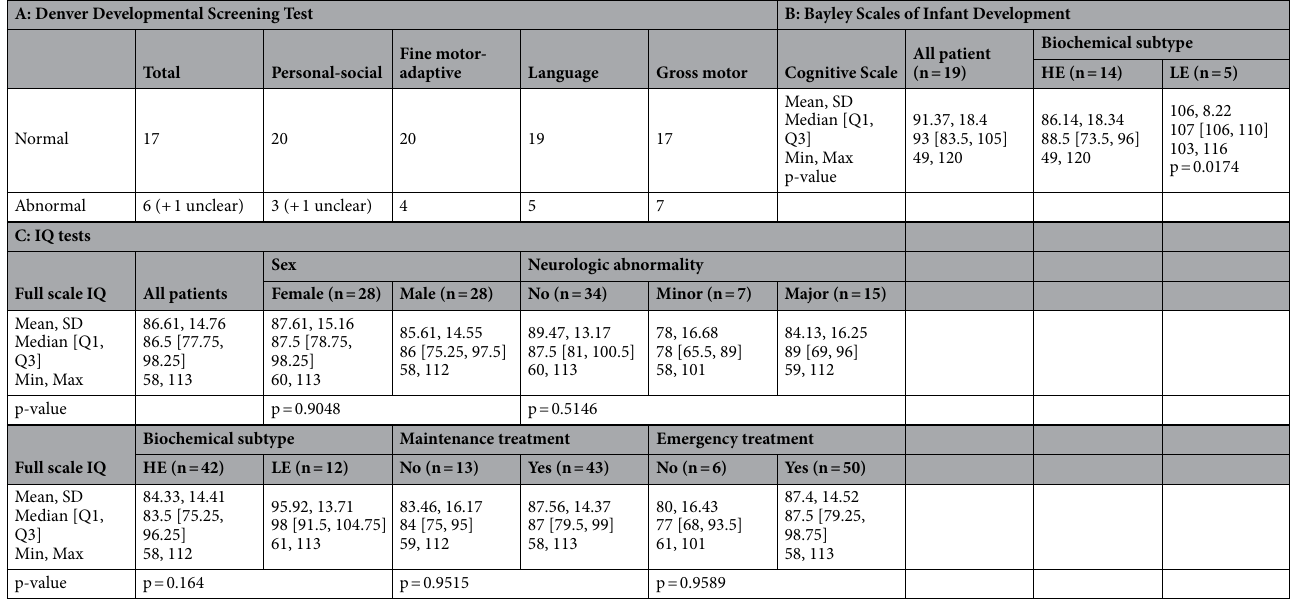
Table 2. Cognitive outcome: development and full scale IQ of individuals identified by NBS. (A) Most patients assessed with Denver Developmental Screening Test showed normal development. (B) Median results in Bayley Scales of Infant Development were normal with HE patients showing lower results than LE patients. (C) Analysis of full scale IQ: Median results of all patients were in the lower average range, while patients with biochemical HE phenotype tended to have lower results than patients with LE phenotype. HE high excreter, LE low excreter, Max Maximum, Min Minimum, n number of patients, NBS newborn screening, Q1 25th percentile, Q3 75th